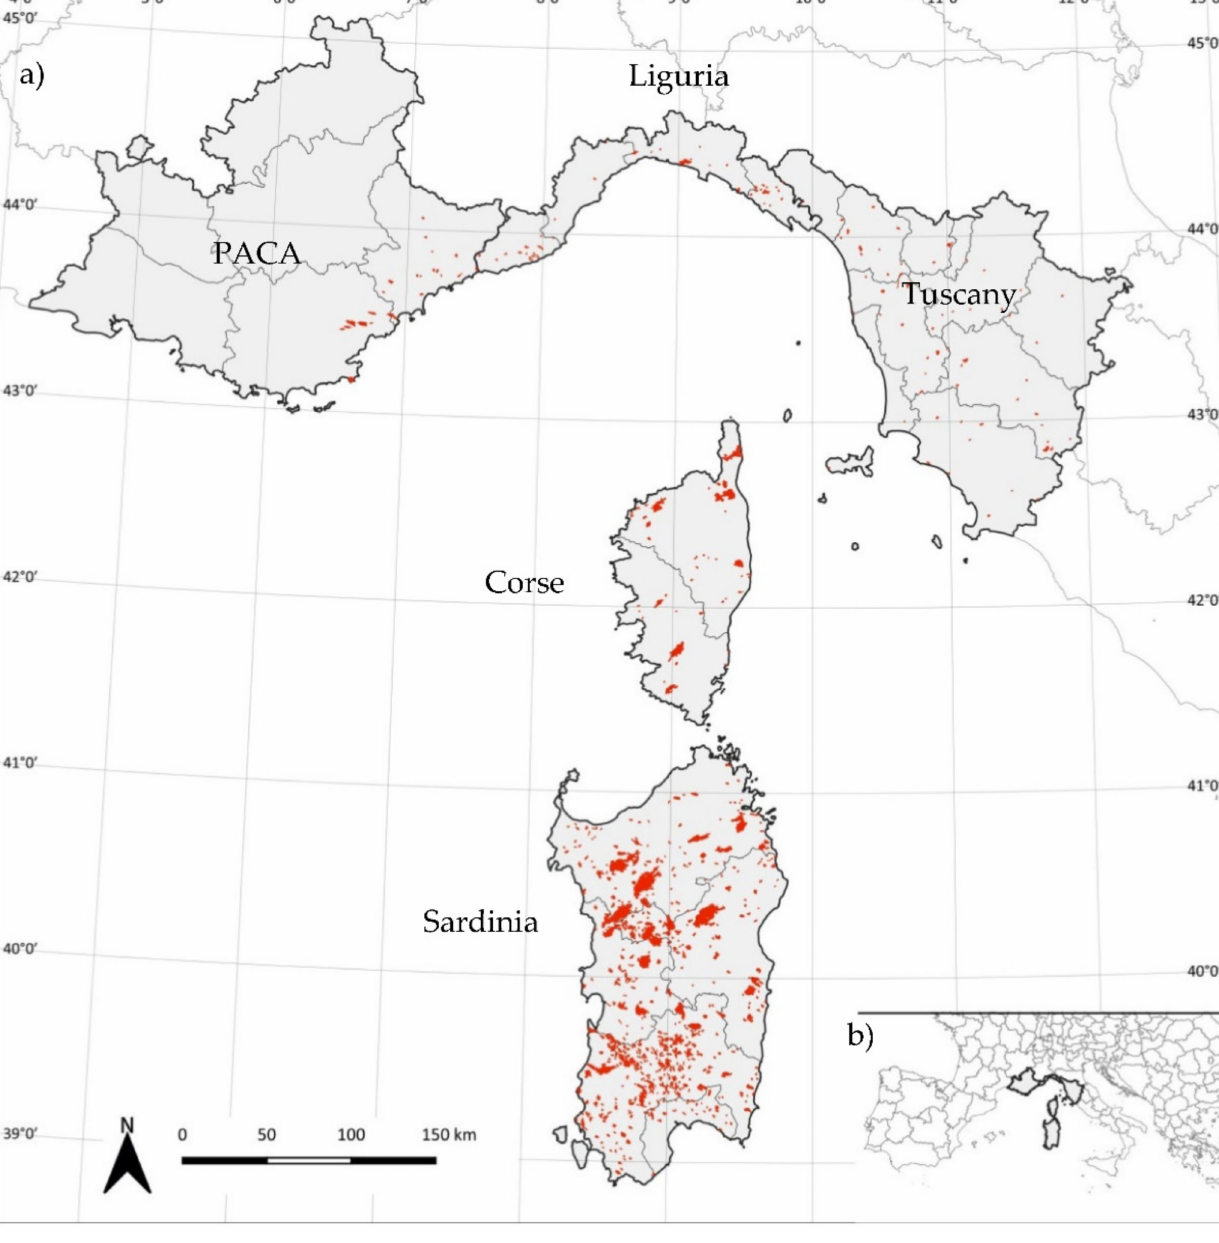
Figure 1. Map of the study area ( a ), within the Mediterranean Region ( b ), which covers the French regions of Provence-Alpes-C ô te d’Azur (PACA) and Corse, and the Italian regions of Tuscany, Liguria, and Sardinia. Fire perimeters included in the study (period 2004–2017) are shown in orange (source ONF and